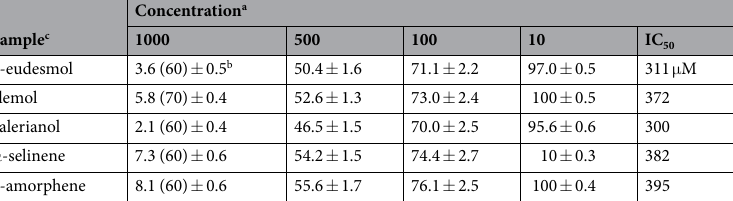
Table 2. Inhibitory effects of treatment with sesquiterpenes on induction of EBV-EA activation by TPA a Mol ratio to TPA (32 pmol/ml) = 100%. b Values represent percentages relative to the positive control value (100%). Values in parentheses are the viability percentages of Raji cells. c β -eudesmol, α -selinene, and γ -amorphene were purified from the cultures of recombinant E. coli strain that possessed the Tps genes mediating the production of respective sesquiterpenes 58 . Elemol was a gift from Takasago International Corporation (Tokyo,